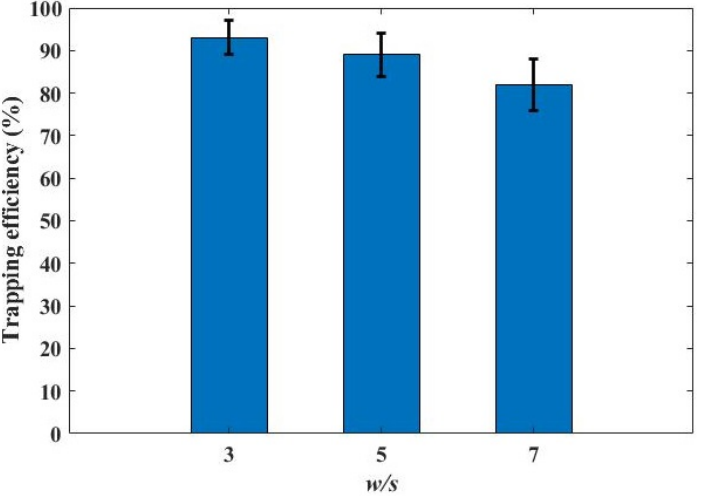
Figure 8. The influence of the ratio between the width of the main channel and the dimension of the gap, i.e., w/s , over the trapping efficiency.